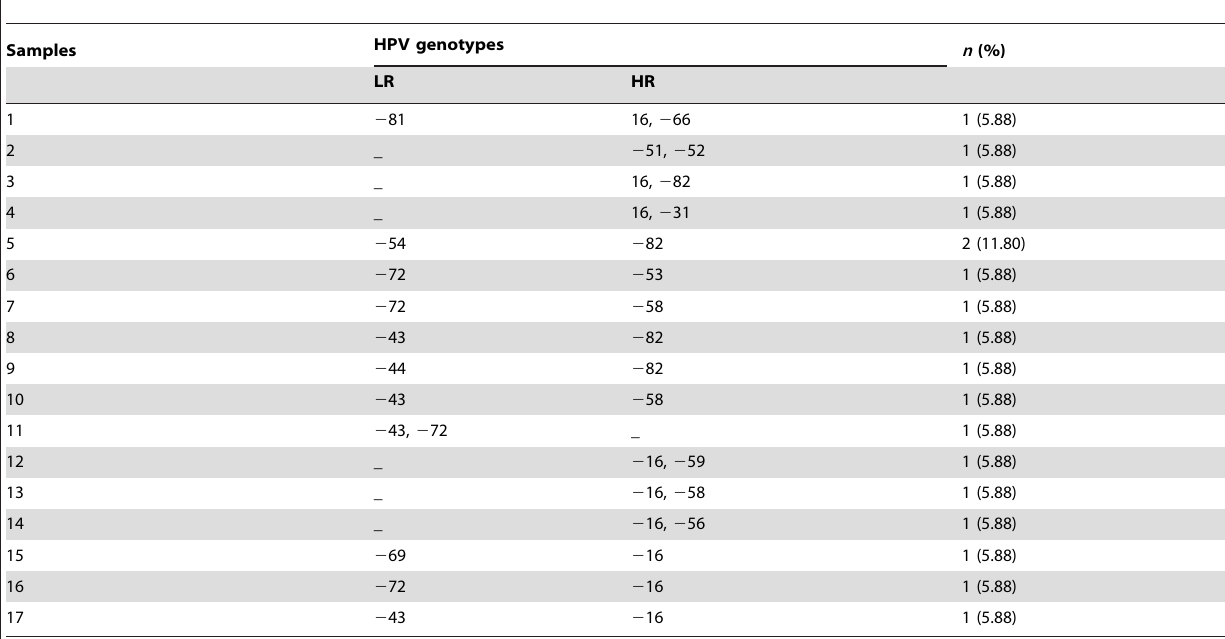
Table 5. HPV genotypes distribution of 17 semem samples with two or more genotypes.